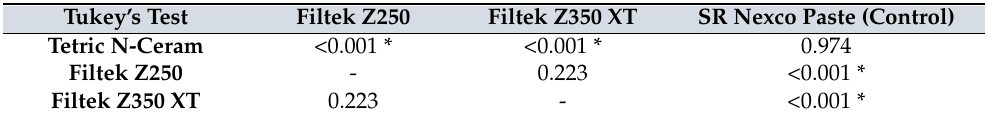
Table 3. Multiple comparisons between the resin composite types without additional dry heat curing, according to Tukey’s post hoc test.